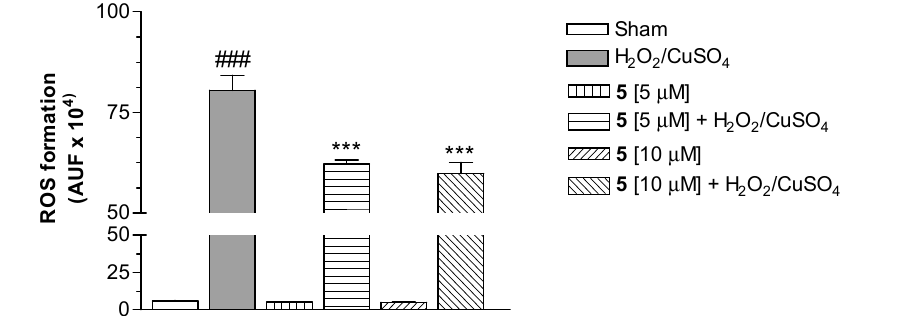
Figure 2. Effect of compound 5 on ROS formation elicited by H 2 O 2 /CuSO 4 in SH-SY5Y cells. The cells were treated with various concentrations of 5 and H 2 O 2 (100 µM)/CuSO 4 (25 µM) for 30 min. At the end of the incubation, intracellular ROS formation was determined using a fluorescence probe, as described in the Materials and Methods section. The arbitrary units of fluorescence (AUF) values are shown as mean ± SD of at least three independent experiments ( ### P < 0.001 versus untreated cells, *** P < 0.001 versus cells treated with H 2 O 2 /CuSO 4 , at ANOVA with Bonferroni’s Post Hoc Test).